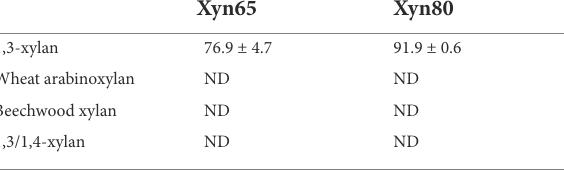
TABLE 4 The substrate specificities of recombinant 1,3-xylanases Xyn65 and Xyn80. Substrate